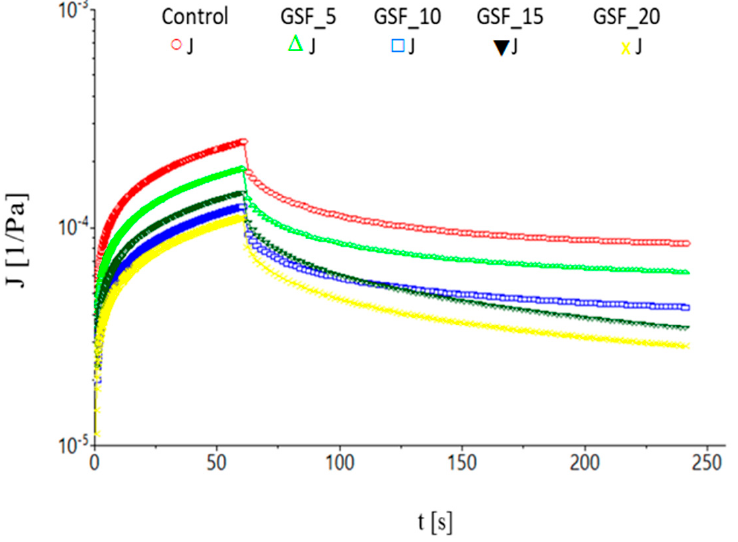
Figure 1. Creep and recovery curves of wheat flour dough with different levels (-o-0%; - ∆ -5%; - (cid:3) -10%; - (cid:72) -15%; -x-20%) of germinated soybean flour